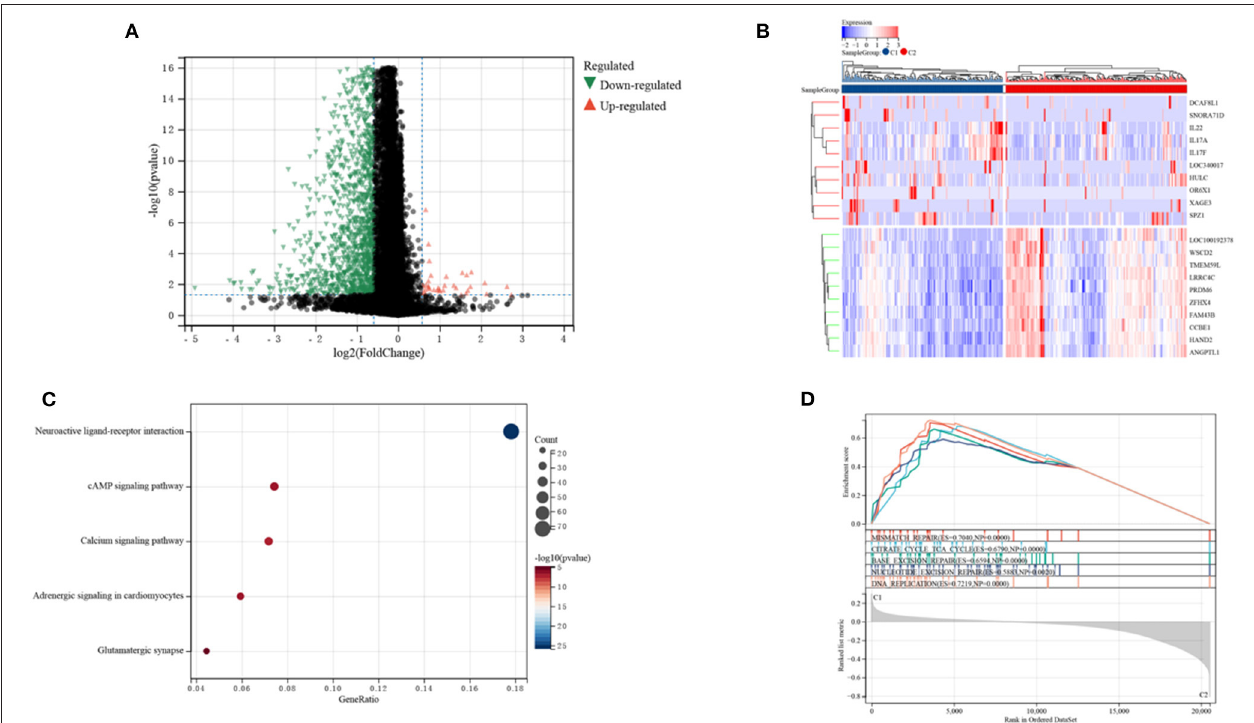
FIGURE 5 | Analyses of differentially expressed genes (DEGs) and of gene function in the two subtypes. (A) Volcano plot showing DEGs by the two subtypes. (B) Heatmap of the top 10 DEGs in each of the two subtypes. (C) KEGG enrichment analyses of DEGs in the two subtypes. (D) GSEA analyses of SRGs in the two